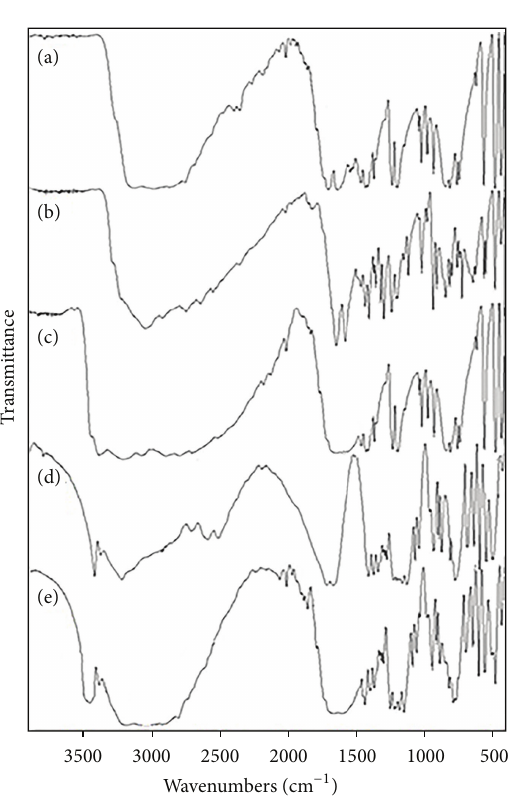
Figure 5: IR spectra of (a) thymine, (b) adenine, (c) thymine- adenine, (d) citric acid, and (e) thymine-citric